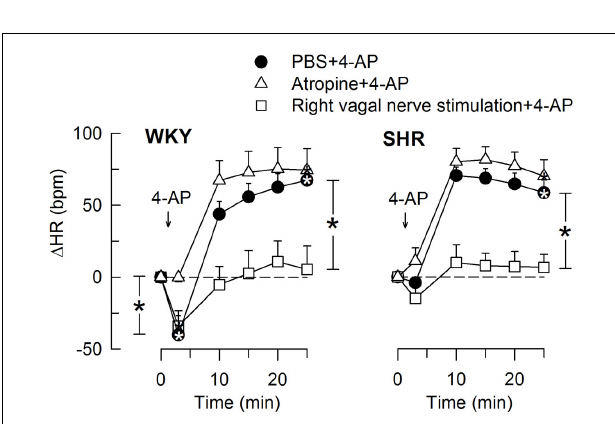
FIGURE 4 |The HR-response to 4-AP after pre-treatment with nAChR antagonist, i.e., the ganglion blocker hexamethonium. Significant responses (* within symbol) and group differences at the initial HR nadir (brackets left of curves) and after 25min (none detected) were as indicated. Hexamethonium reduced baseline HR in both strains ( Table 2 ). * – P ≤